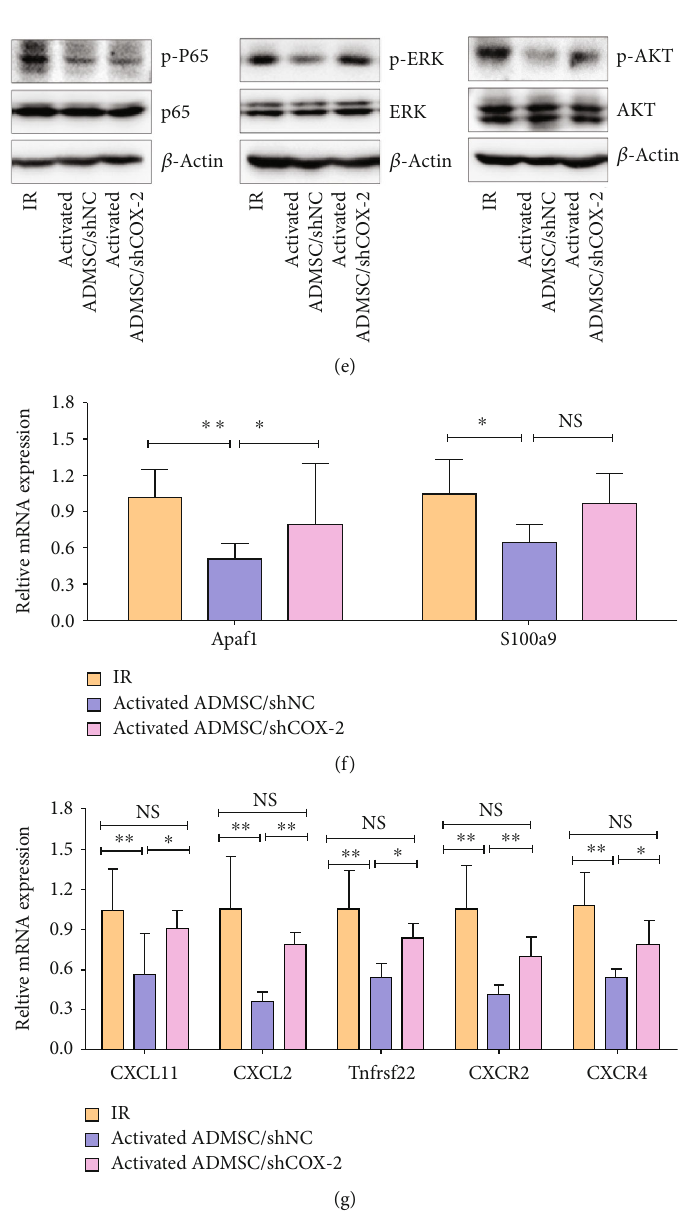
Figure 7: GO enrichment analysis and KEGG pathway analysis were used to explore the possible mechanism of activated ADMSC for treatment of intestinal IR injury. (a) GO enrichment analysis revealed that di ff erentially expressed mRNAs were involved in “ biological process, ” “ cellular component, ” and “ molecular function ” processes. (b) Deregulated mRNAs participated in multiple biological functions like “ neutrophil chemotaxis, ” , “ in fl ammatory response ” , “ chemotaxis ” and “ defense response ” . (c) KEGG pathway analysis showed that several pathways (NF- κ B-P65, MAPK-ERK, and PI3K-AKT pathways) were involved in activated ADMSC for treatment of intestinal IR injury. (d) Results from western blot showed that activated ADMSC inhibited phosphorylation of P65, ERK, and AKT that were induced by IR injury. (e, f) Silencing of COX-2 impaired the e ff ect of activated ADMSC on inhibition of the seven mRNA expressions and inaction of NF- κ B-P65, MAPK-ERK, and PI3K-AKT pathways in intestinal IR-injured